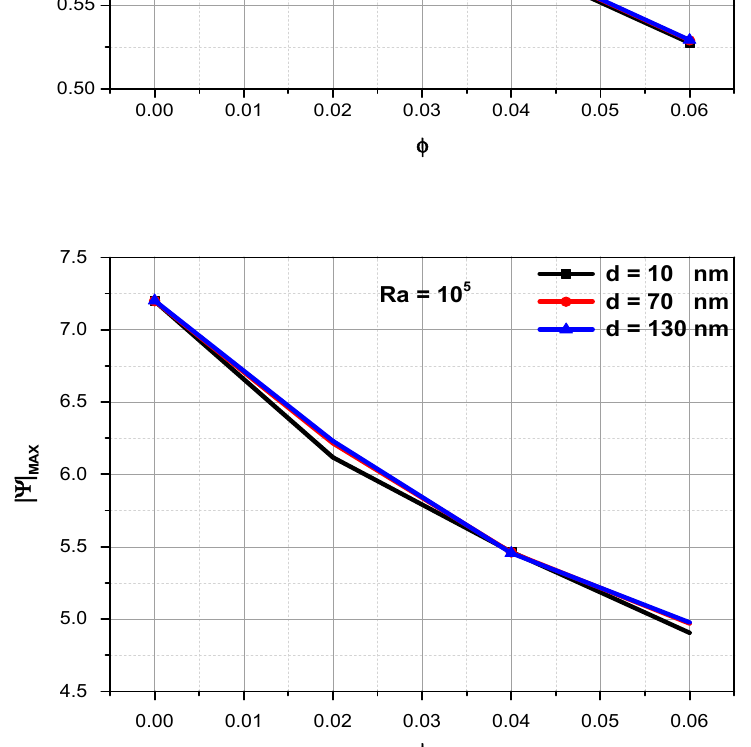
Figure 11. The variation between the stream function and the solid volume fraction for various values of the Rayleigh number and nanoparticle diameter at (Ha = 30).